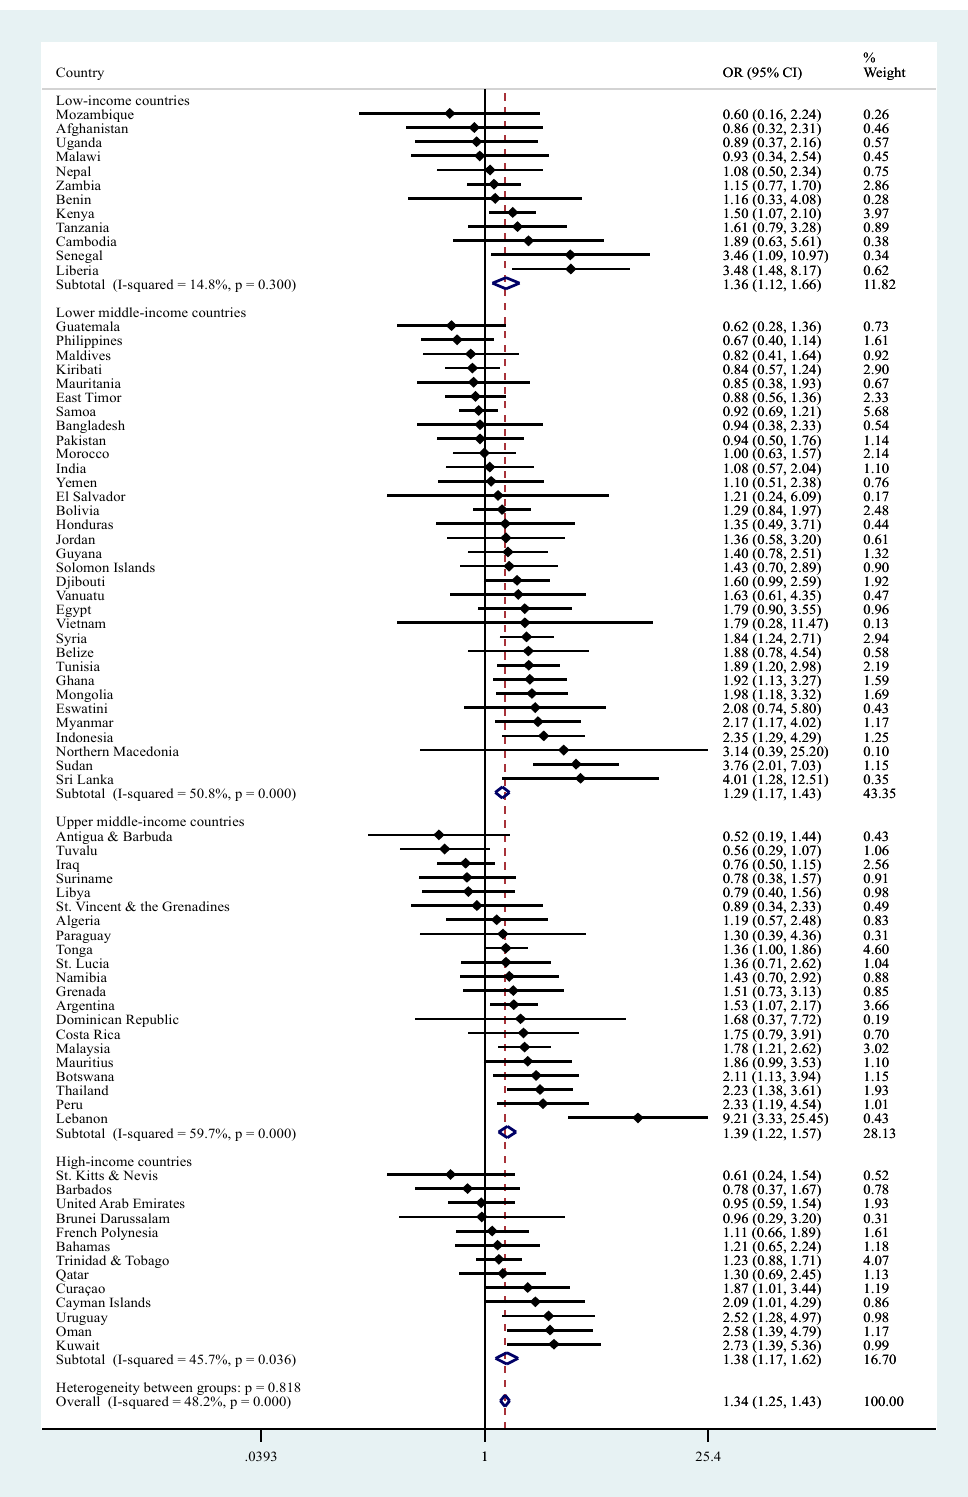
Heterogeneity between groups: p = 0.818 Overall (I-squared = 48.2%, p = 0.000)